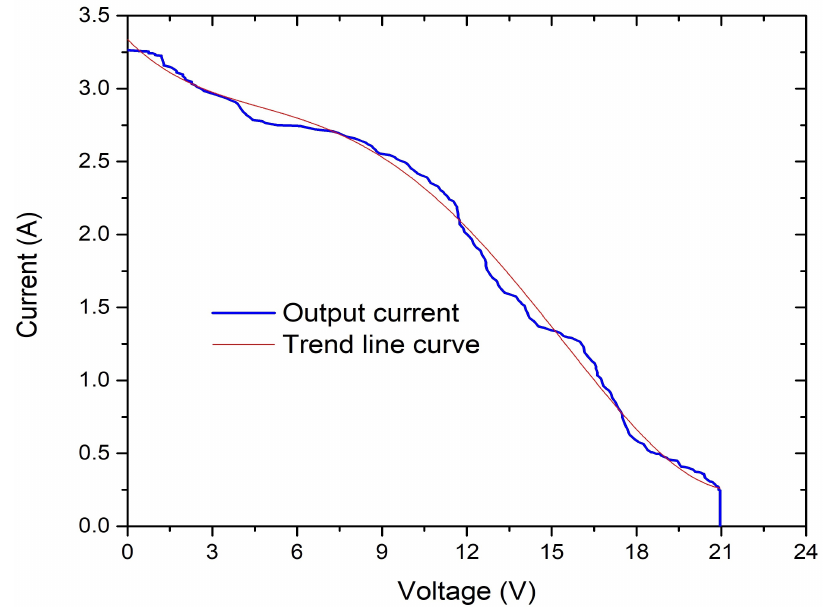
Figure 4. The trend line of the V–I curve of the